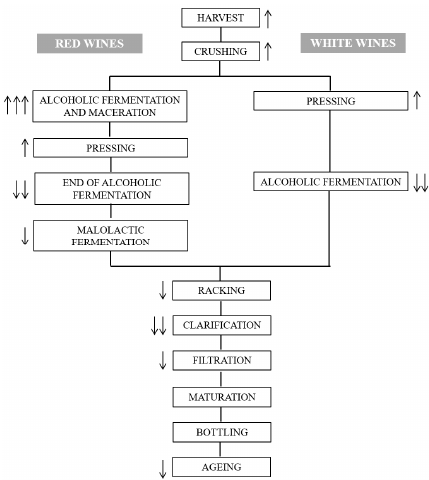
Figure 2. Schematic representation of winemaking process. Steps for red (left) and white (right) wine production are indicated. The arrows are related to the increase or decrease in Ochratoxin A (OTA) content during each step.